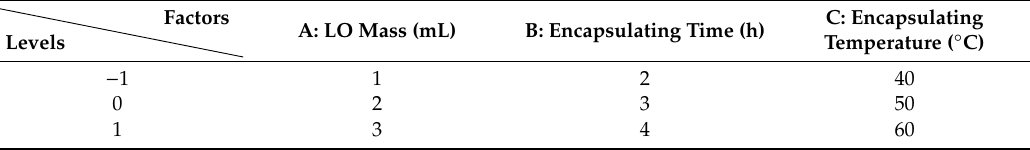
Table 1. Independent variables and their levels for the Box-Behnken design (BBD) used in the response surface methodology (RSM). LO: lavender essential